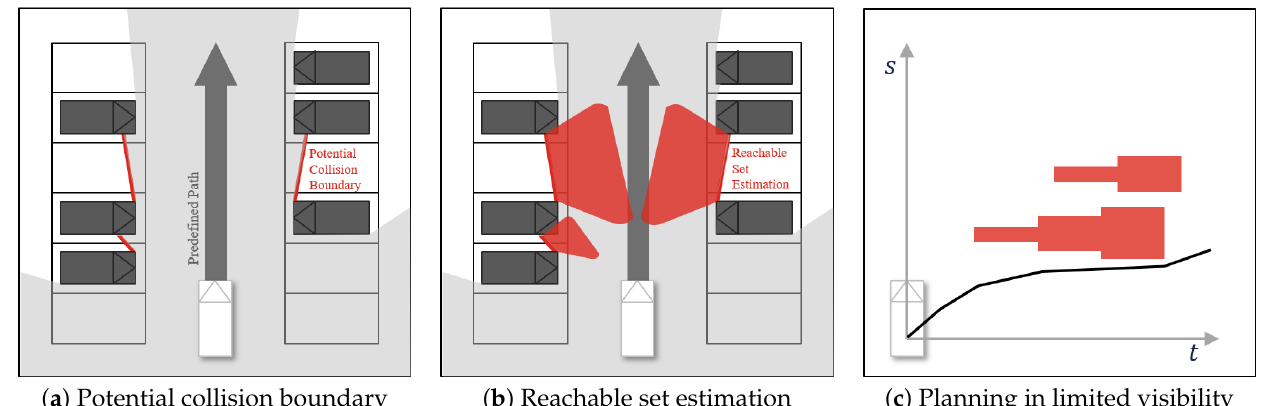
Figure 1. An overall architecture of limited visibility aware motion